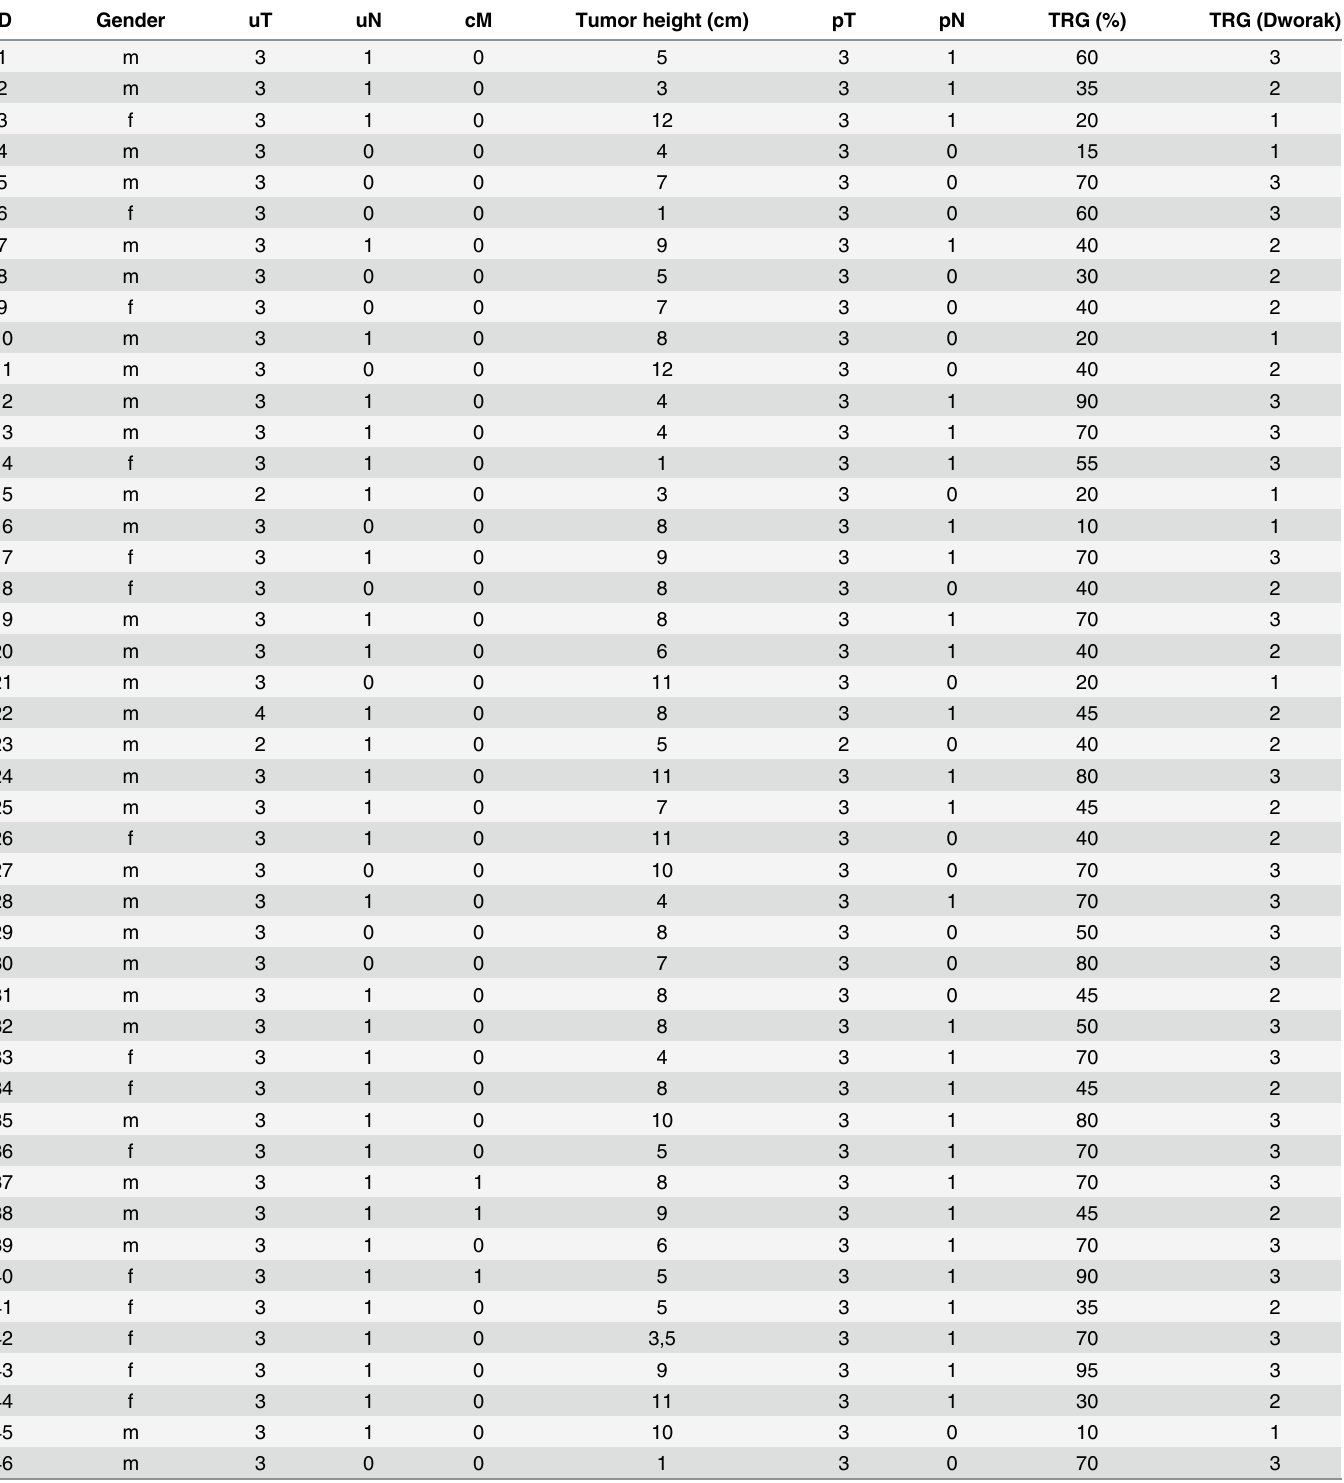
Table 1. Clinical Data with Tumor Regression